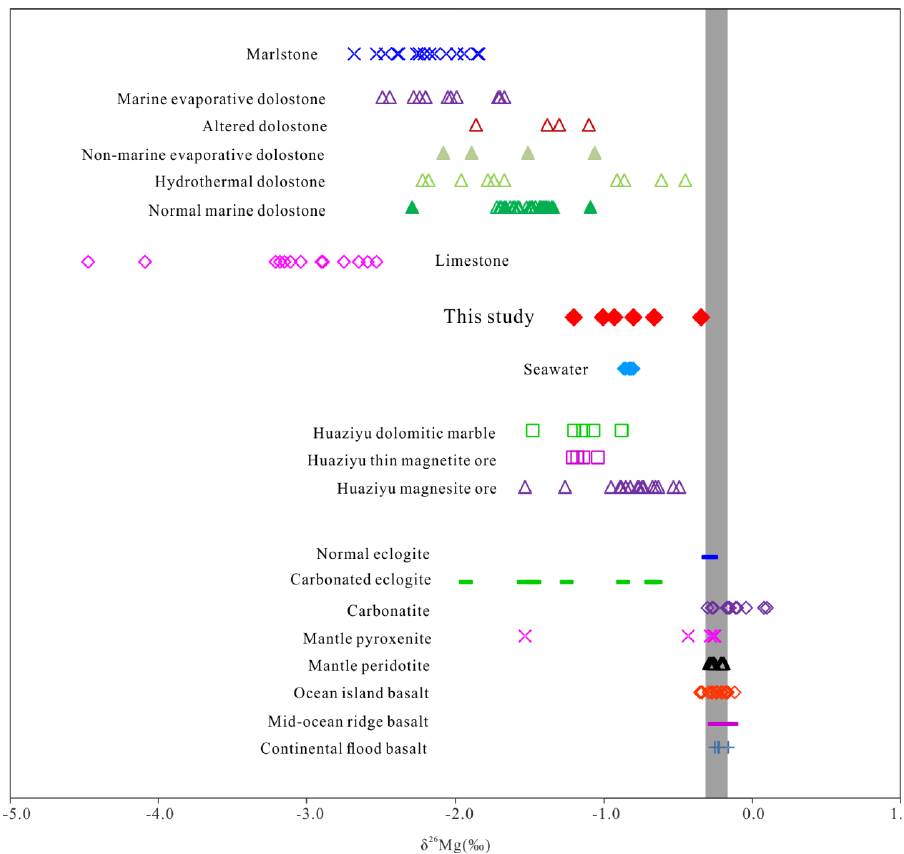
Figure 8. Compilation of Mg isotope data for the Zhaoanzhuang iron deposit and published data for carbonate rocks, igneous rocks, and modern seawater for comparison. The modern seawater data are from [61,70,144]. The marlstone data are from [121]; the limestone data are from [50,121], the normal marine dolostone data are from [50,119,120]; and all of the other dolostone data are from [119]. The Huaziyu magnesite and dolomitic marble data are from [145]. The igneous rock data are from [60,61,141,143]. The normal eclogite and carbonated eclogite data are taken from [140]. The solid grey vertical band represents the chondritic δ 26 Mg value of –0.25 ± 0.07‰ [47,59]. Because metamorphic dehydration [64,66,73] and serpentinization [109] result in insignificant amounts of Mg isotopic fractionation, the δ 26 Mg values of the seven samples analyzed in this study can potentially reflect the primitive Mg isotopic composition of the Zhaoanzhuang iron deposit. These samples have whole-rock δ 26 Mg values ranging from − 1.20‰ to − 0.34‰, which is inconsistent with the magnesium isotopic compositions of magmatic rocks, but falls into the range of dolostone values ( δ 26 Mg = − 2.49‰ to − 0.45‰) (Figure 8; [119]), and is approximately 0.7‰ higher than that of normal marine sedimentary dolostones ( − 2.29‰ to − 1.09‰; [50,120]). Metasomatic mantle-derived rocks, such as carbonated eclogites, garnet–websterite, and phlogopite–pyroxenite, also have light Mg isotopic compositions. This is due to the fact that sedimentary carbonate rocks have low δ 26 Mg values, so metasomatism of the mantle by the addition of silicate melts and/or sedimentary carbonate-bearing fluids from an ancient subducted oceanic slab lowers the Mg isotopic composition of the mantle-derived rocks [64,141]. Therefore, if the Mg in the Zhaoanzhuang iron deposit was sourced from ultramafic magma, these low δ 26 Mg values are most likely the result of mixing with sedimentary carbonate or carbonate-bearing fluid. The possible mixing processes could be due to either subduction of an